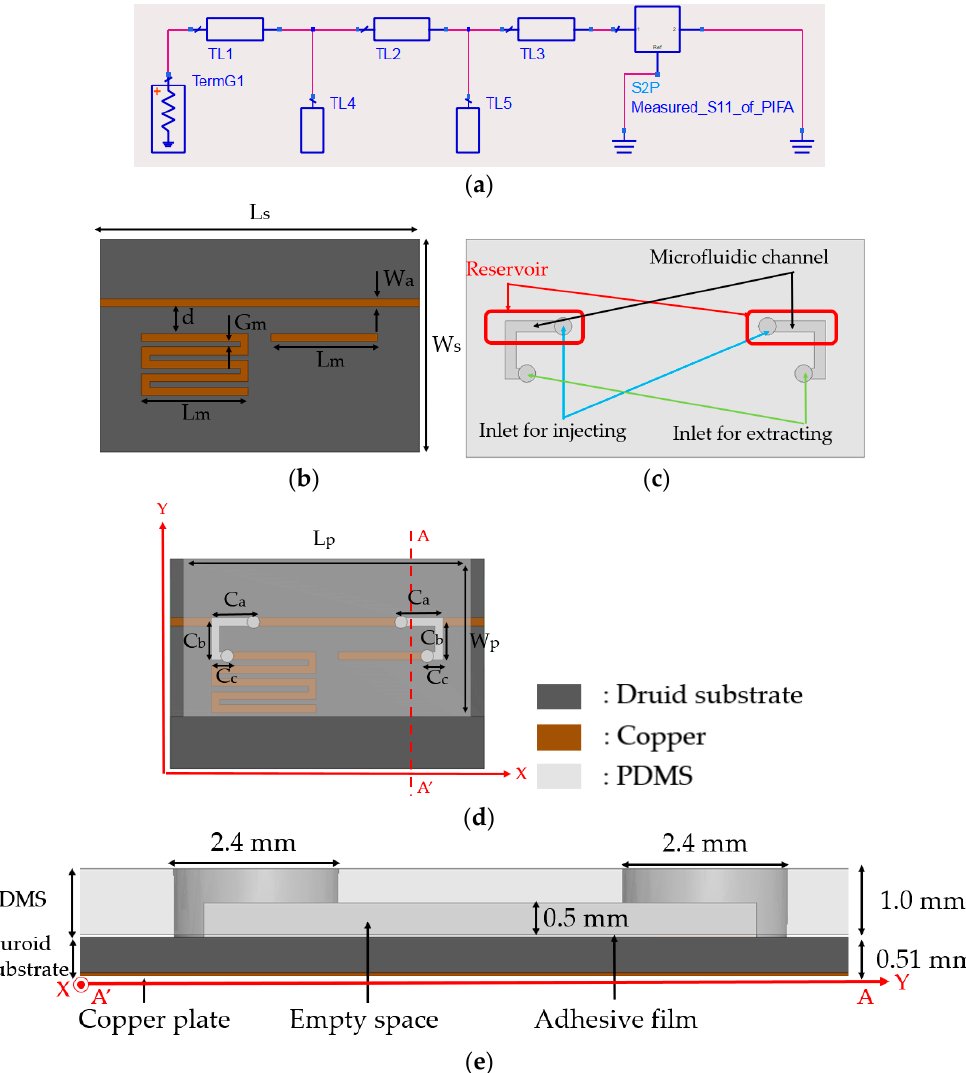
Figure 3. ( a ) Measurement setup of PIFA at touched and untouched states; ( b ) Photograph of the 3D printed mockup with PIFA; ( c ) measured input impedances on Smith Chart at touched and untouched states; ( d ) measured reflection coefficients at touched and untouched states; and, ( e ) Side view of the proposed microfluidic impedance tuner.